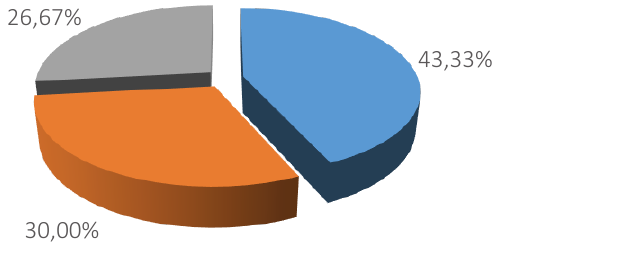
Figure A2. Protection and conservation of the environment